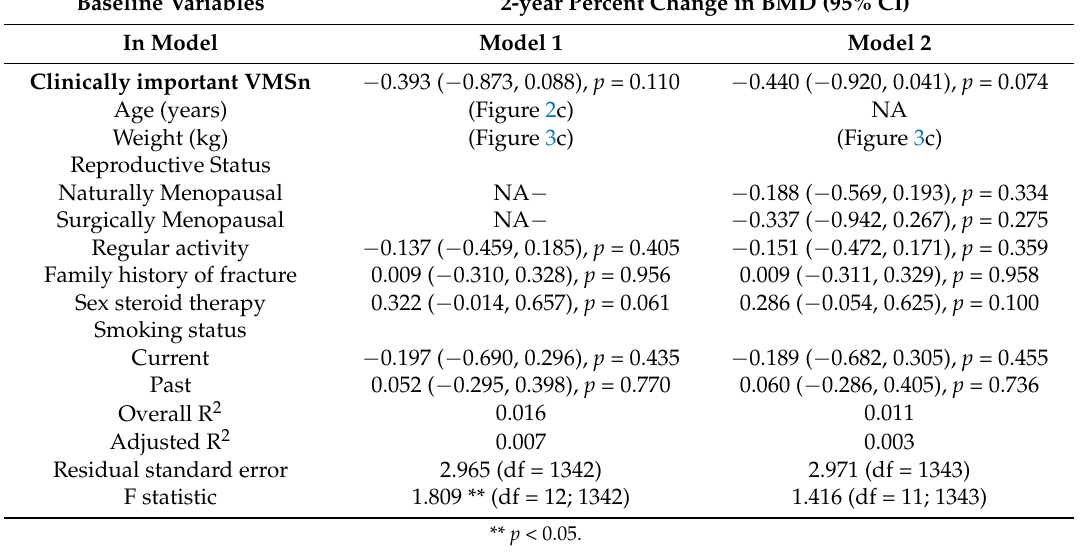
Table 4. Multivariable Linear Regression Models without interactions for 2-year Percentage Change in areal BMD (95% confidence intervals) at Total Hip in Women ages 43–63 in the Canadian Multicentre Osteoporosis Study (CaM os ).